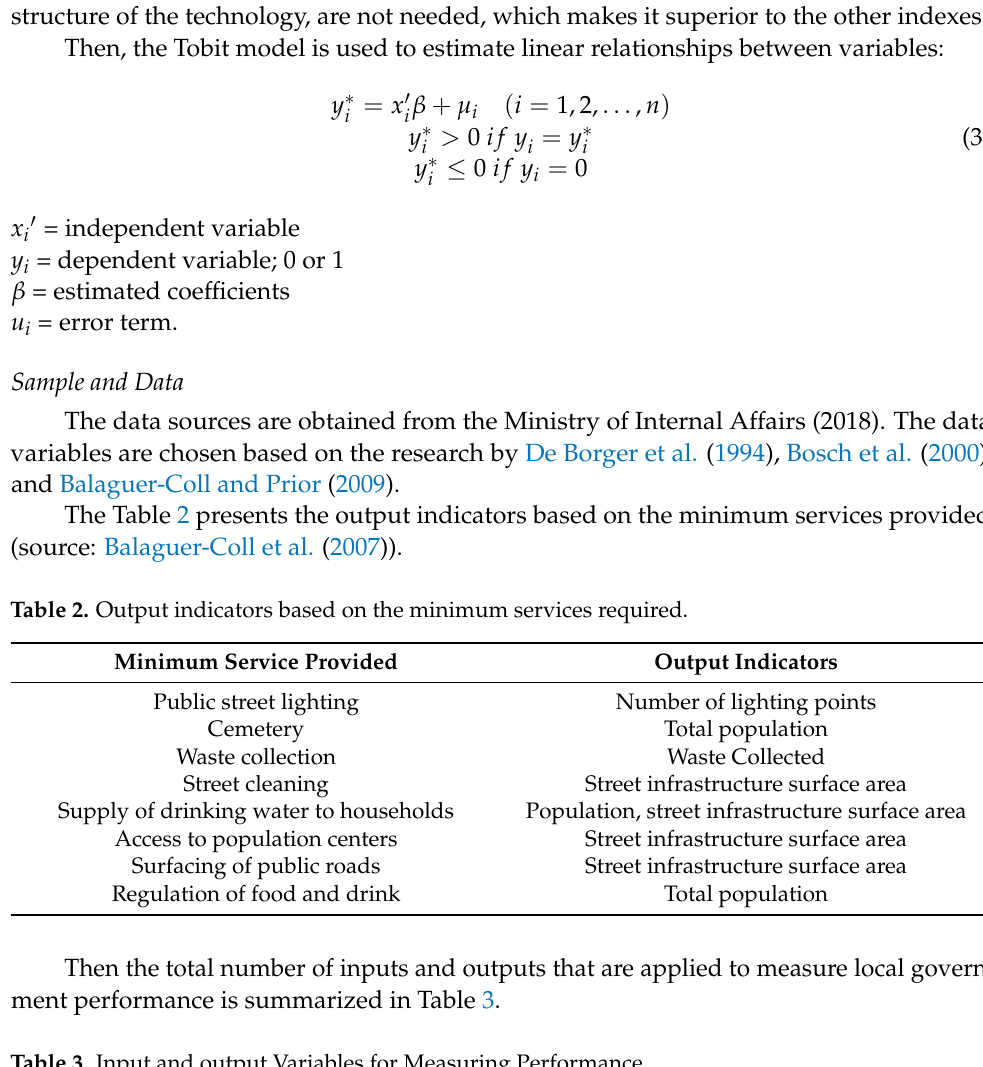
Table 3. Input and output Variables for Measuring